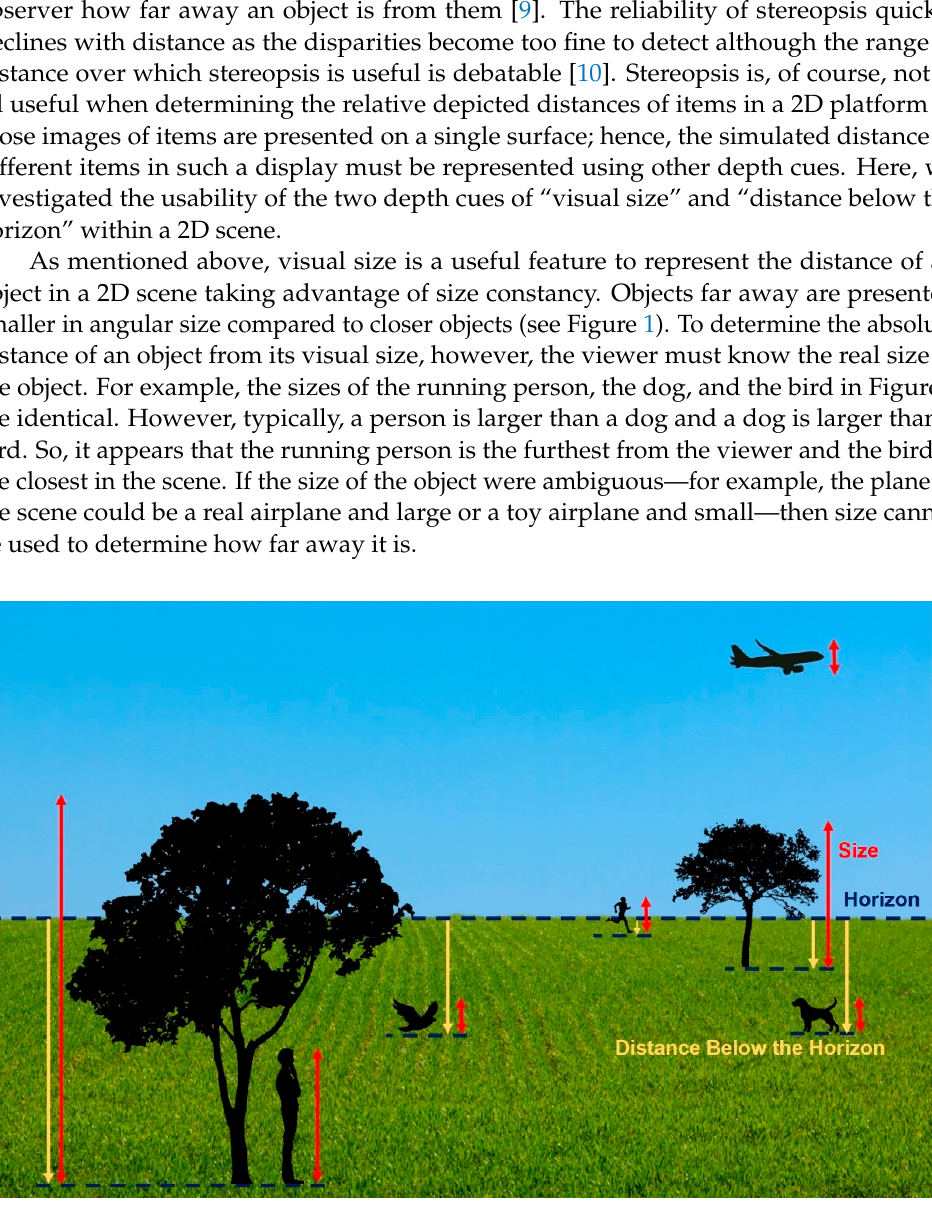
Figure 1. Example of a 2D scene with objects at various distances. Distances are represented with the objects’ ( 1 ) size —objects of smaller visual size (e.g., the running person and the tree on the right side) are perceived as further away compared to the same objects of larger visual size (e.g., the standing person and the tree on the left of the figure); and their ( 2 ) distance below the horizon —objects placed closer to the horizon (the running person and the tree on the right side) are perceived as further away compared to objects further below the horizon (e.g., the standing person and the tree on the left side). The ground plane and the horizon play big roles in depth perception in this example. The running person, the dog, the airplane, and the bird in this scene are all the same visual size. When comparing the person and the dog, it appears obvious the person is further away. However, when comparing them to the bird or the plane, it is ambiguous whether the bird/airplane is: (i) flying at a distance close to the viewer and is smaller in physical size or (ii) flying at a far distance but is larger in size.